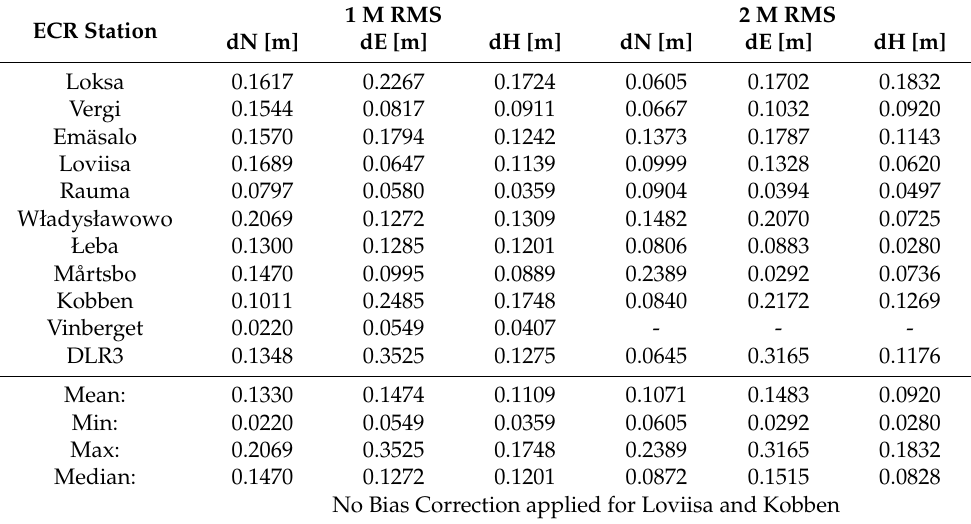
Table 5. Root mean square (RMS) values of the once-monthly (1 M) and bimonthly (2 M) solutions of each station. Loviisa and Kobben were computed without bias correction due to computational issues for single observation intervals. DLR2 is excluded in the table, as its performance significantly changed after each repair of the